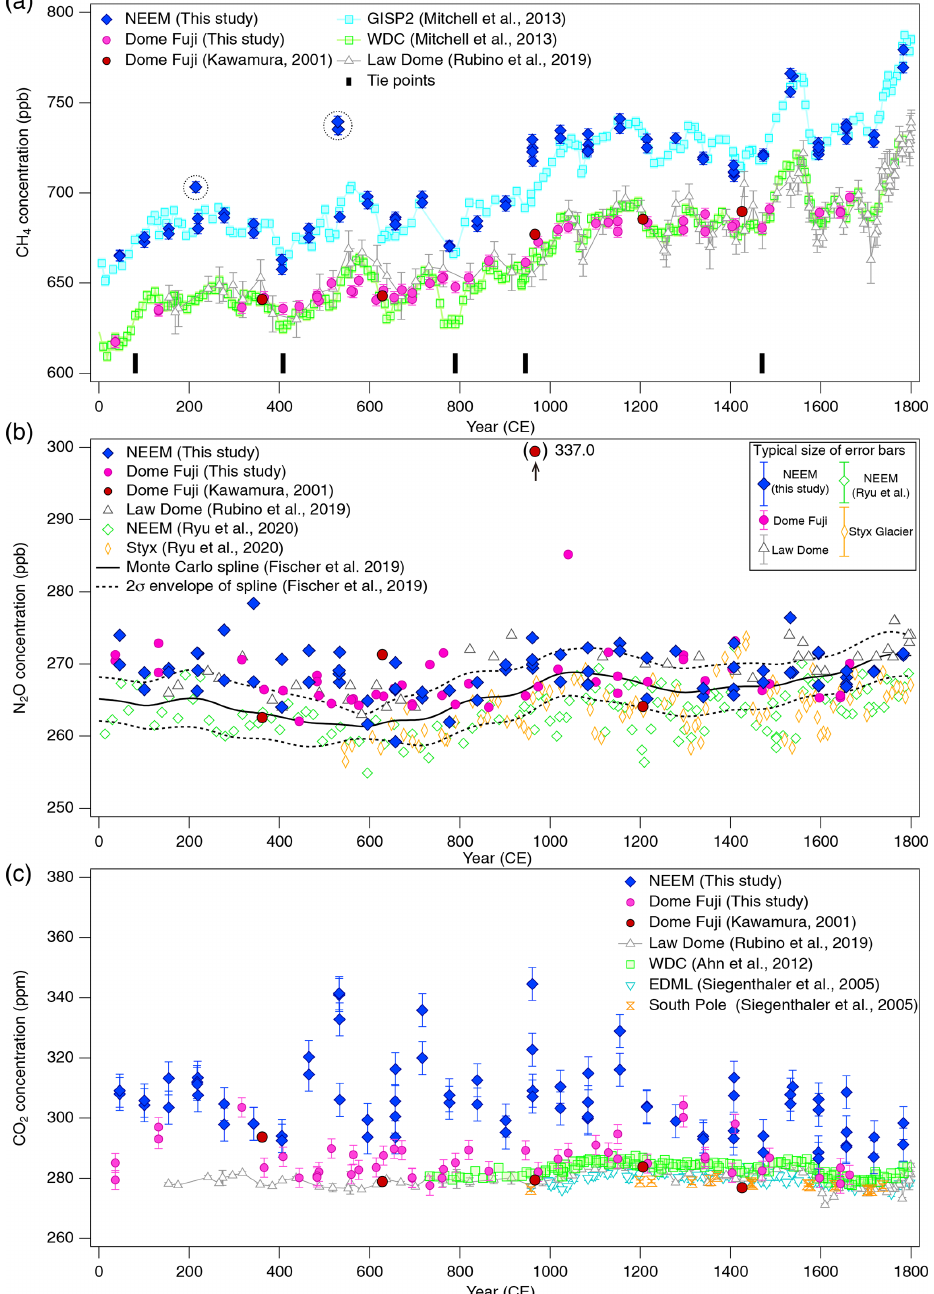
Figure 10. (a) CH 4 , (b) N 2 O and (c) CO 2 concentrations for 0–1800CE from the DF and NEEM ice cores measured with our new method, and the comparison with published records (Ahn et al., 2012; Kawamura, 2001; Kawamura et al., 2007; Mitchell et al., 2013; Rubino et al., 2019; Ryu et al., 2020; Siegenthaler et al., 2005). Details are summarized in Table A1. The DF data are placed on the WDC05A chronology by placing five tie points between the CH 4 variations of the DF and WD cores – thick tick marks at the bottom of panel (a) , and all the other data are placed on the respective (published) timescales. Five CH 4 outliers at two depths in the NEEM core, highlighted by dotted-line circles, are interpreted as natural artifacts (see text and Fig.